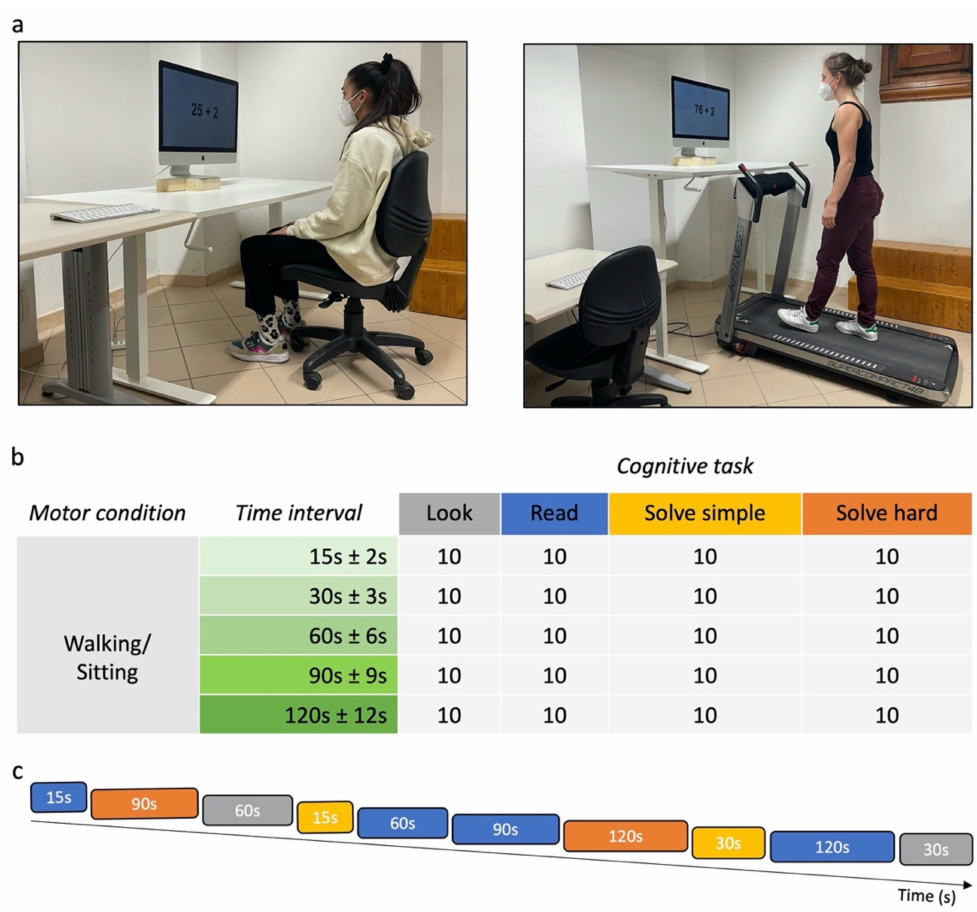
Figure 1. Experimental design. ( a ) Experimental set-up in sitting ( left panel ) and walking condition ( right panel ). ( b ) Number of trials per condition, time interval and cognitive task. Observers performed 10 trials for all possible combinations of time intervals and cognitive tasks in each motor condition. ( c ) Trial randomization in a block. Example of a block of 10 trials. Grey: look task; blue: read task; yellow: solve simple task; orange: solve hard